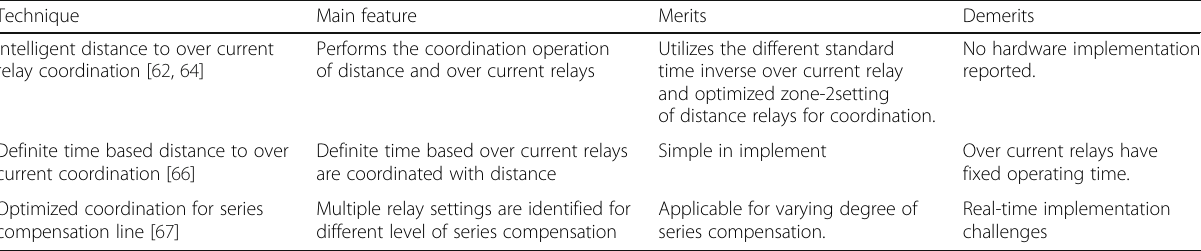
Table 2 Summary of different techniques used for protection coordination of sub-transmission systems Technique Main